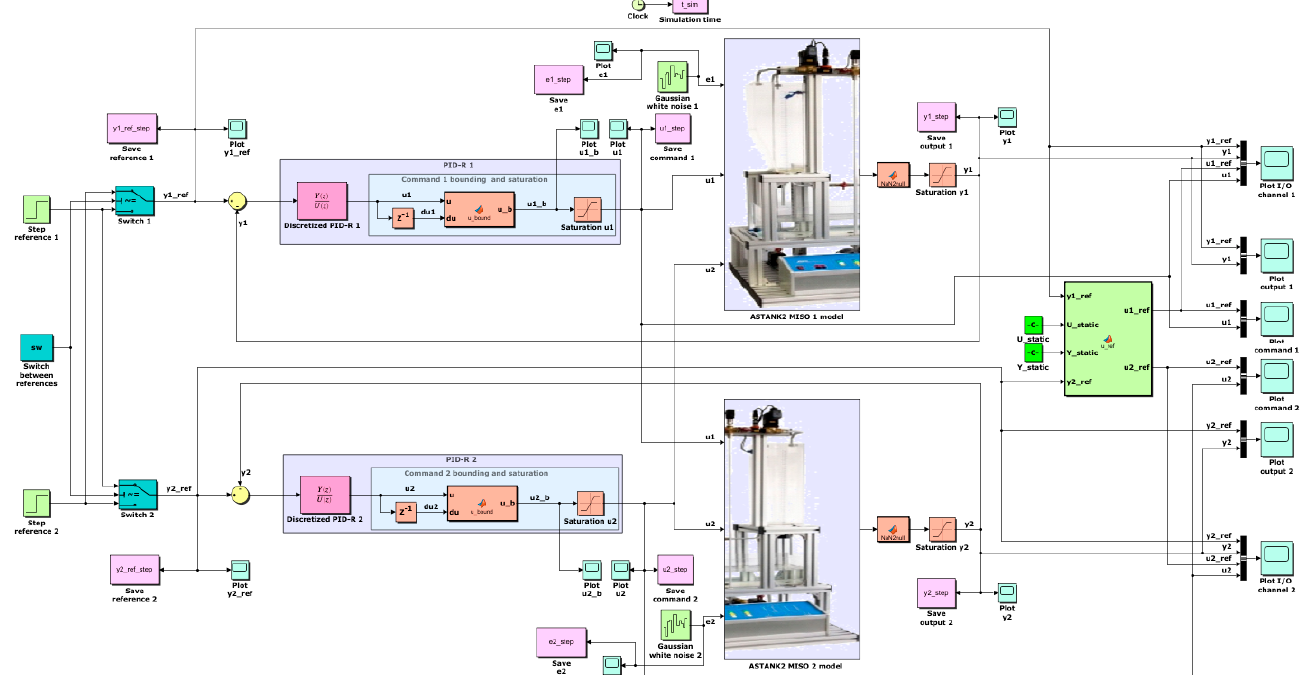
Figure 11. Closed loop PID-N-ASTANK2 SIMULINK model.